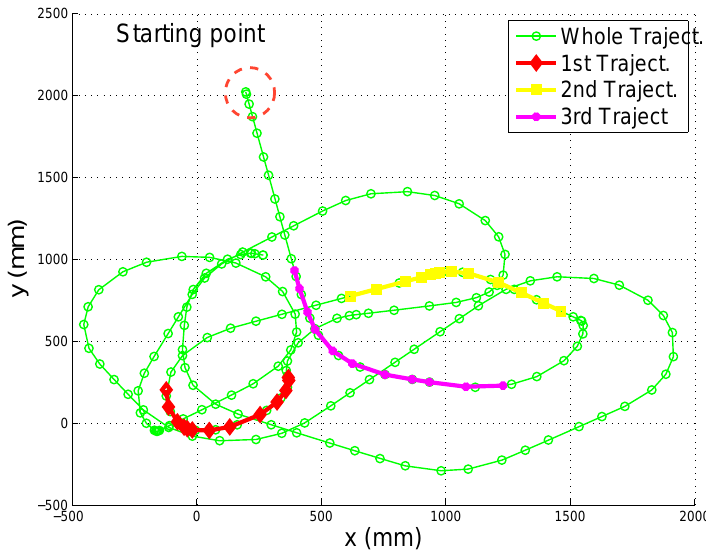
Figure 11. Intervals of robot’s trajectory used for